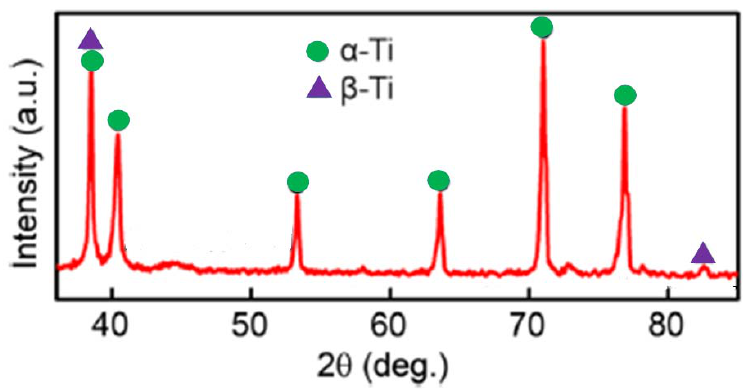
Figure 2. X ‐ Ray Diffraction of Ti ‐ 6Al ‐ 4V MMC . Figure 2. X-ray Diffraction of Ti-6Al-4V MMC.